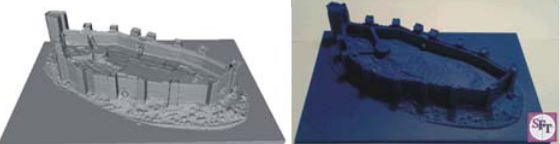
Figure 17. 3D model of the Burgalimar Castle. Left: stl file format model. Right: 3D plastic printed model (3D RepRap x400 printer).